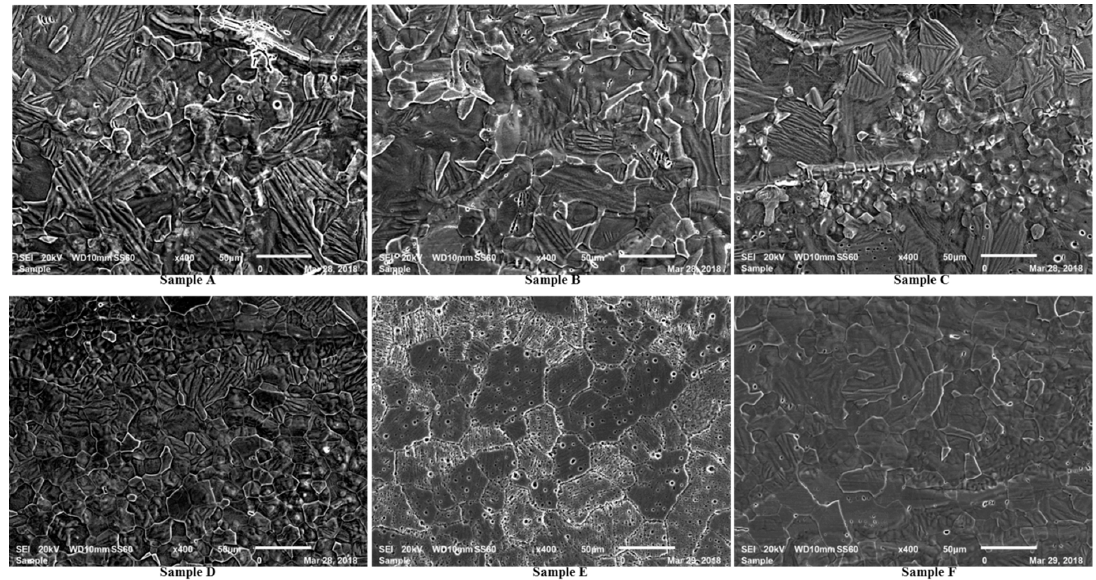
Figure 7. High magnification images of the as-built samples.